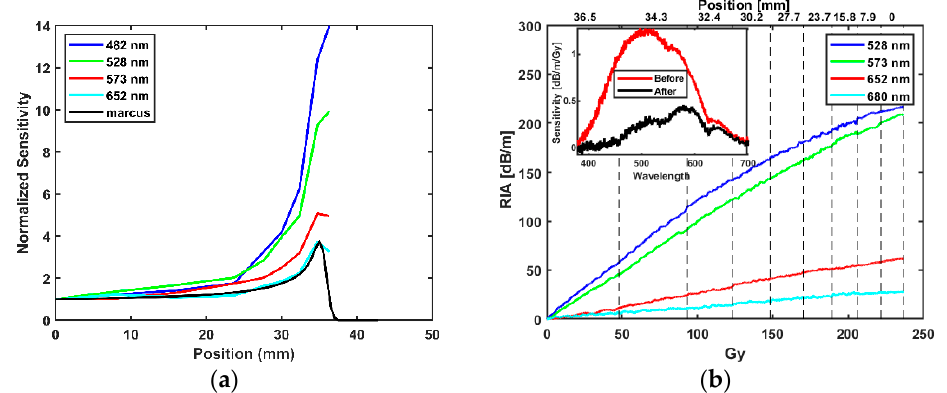
Figure 7. ( a ) Bragg peak detected in the water phantom by the RIA as measured with the INO OF at selected wavelengths. ( b ) RIA from accumulation of dose converted to Gy from Table 4 at selected wavelength where grid lines (position (mm)) indicate estimated delivered dose at that position; inset graph shows the comparison of sensitivity measured at 36.5 mm at the start of all proton irradiation (red) and afterwards (black).